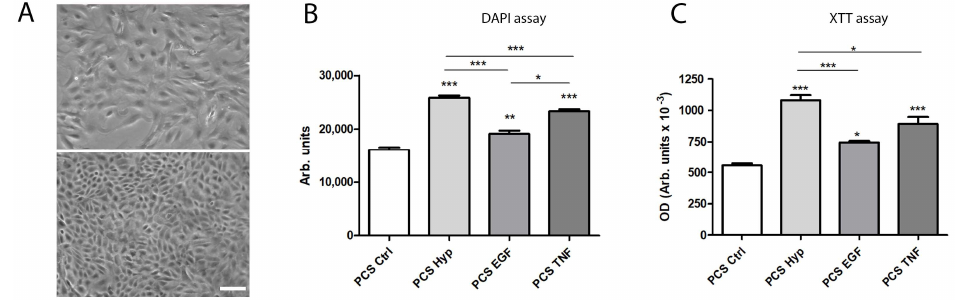
Figure 5. Effect of processed culture supernatant (PCS) after preconditioning (by Hyp, EGF, or TNF) or control culture (Ctrl) on the proliferation and viability of epithelial cells. ( A ) Characteristic phase contrast microscopy of subconfluent (above) and confluent (below) murine renal tubular epithelial cells in culture (bar: 100 µ m); ( B ) DAPI assay: cell proliferation was determined by a fluorometric assay using 4,6-diamino-2-phenylindole (DAPI), measuring the DNA content as an indirect determination of proliferation, after incubation with PCS for 72 h. Fluorescence was measured in a fluorescence reader (355 nm ex/460 nm em), and expressed as arbitrary units (mean ± SD, n = 6); ( C ) XTT assay: cell viability of mTEC was measured after incubation with PCS for 72 h. The XTT assay was performed and optical density (OD) was measured in a microplate reader at 490 nm vs. 650 nm (arbitrary units, mean ± SD, n = 6). * p < 0.05, ** p < 0.01, *** p < 0.001 versus control and among each preconditioning